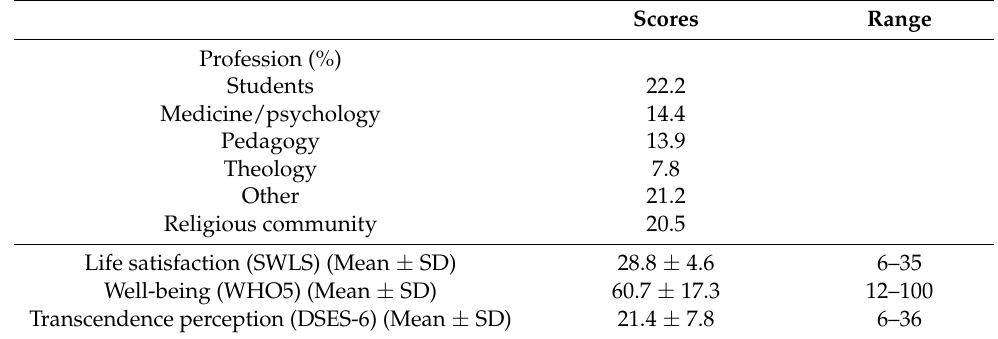
Table 1. Description of the sample (N =